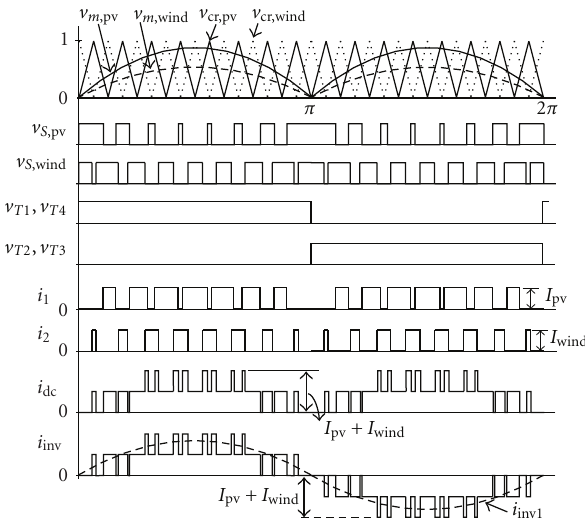
Figure 10: The steady-state waveforms of the proposed phase- shifted PWM multicarrier